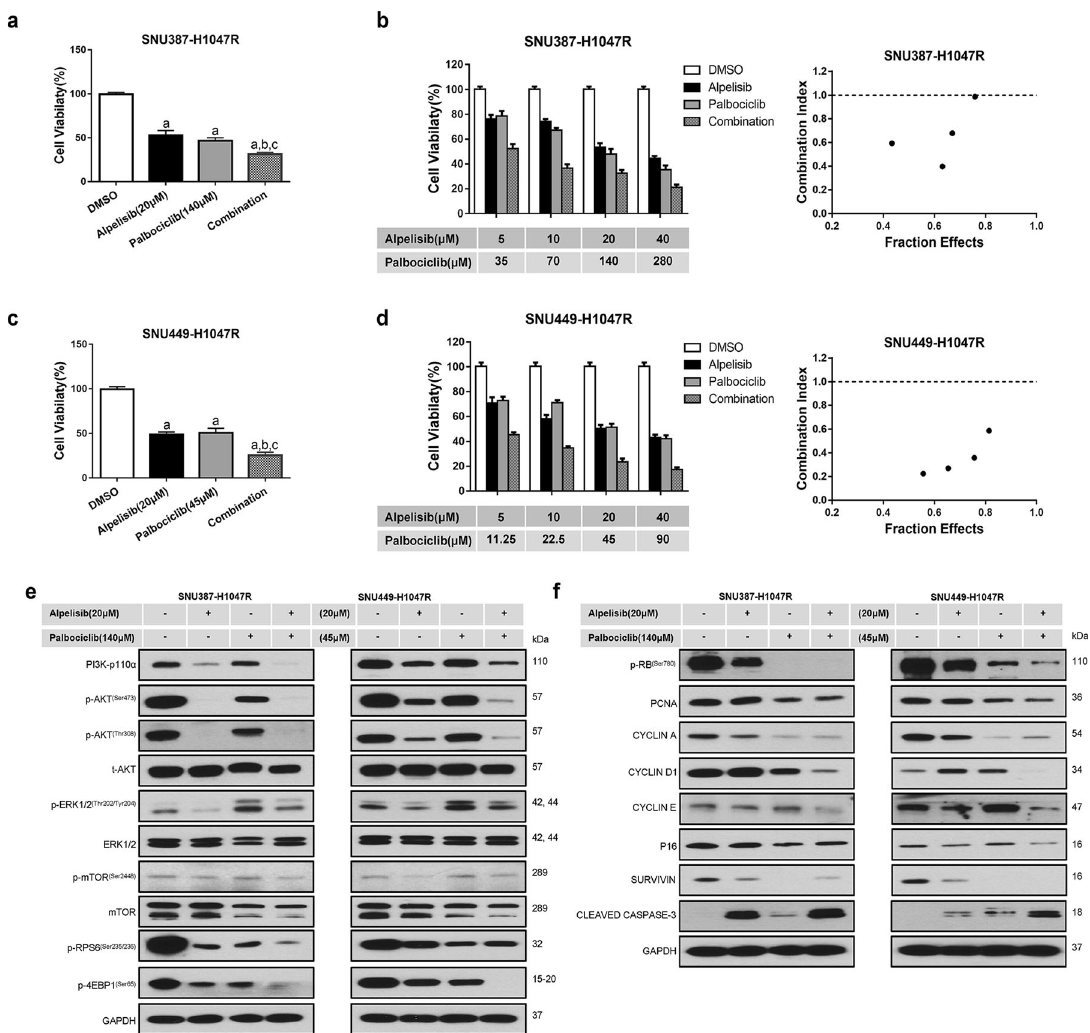
Fig. 4 Effects of combined alpelisib/palbociclib treatment on SNU387-H1047R and SNU449-H1047R cell lines. Transfected cell lines were seeded in 24-well plates at 2.5 × 10 5 and treated for 48 h. a, c Combined alpelisib/p a lboci c lib treatment reduced cell proliferation in SNU387- H1047R and SNU449-H1047R cells. b , d The enhanced inhibitory effect of the alpelisib/palbociclib combination on HCC in vitro growth is a synergistic action. e Western blot analysis of AKT / mTOR and Ras/MAPK pathways in SNU387-H1047R and SNU449-H1047R cell lines. f Western blot analysis of proliferation signaling pathways in SNU387-H1047R and SNU449-H1047R cell lines. Tukey – Kramer test: at least P < 0.05. a vs. DMSO; b vs. Alpelisib; c vs.